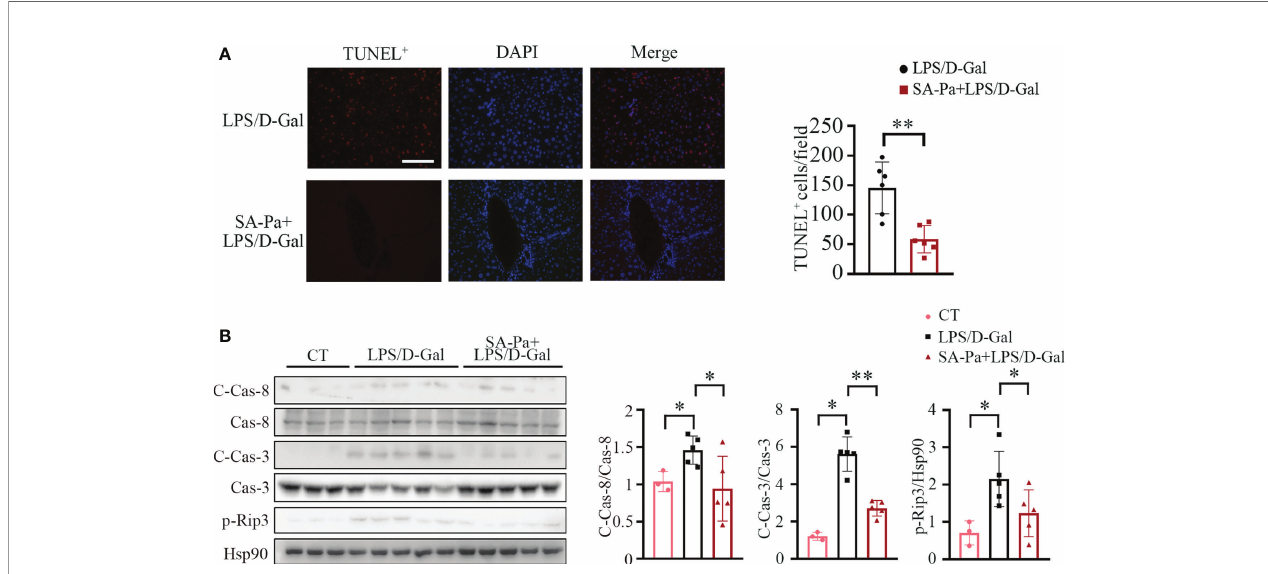
FIGURE 6 | SA-Pa attenuated cell death after the LPS/D-Gal injury. (A) Representative pictures for TUNEL + staining in the liver (left) and quantitative results (right). (B) Western blots (left) and quantitative results (right) for C-Casp-8/Cas-8 (cleaved-Caspase-8/Caspase-8), C-Cas-3/Cas-3, and p-Rip3 levels. (CT group, n = 3; LPS/D-Gal group, n = 5 – 6; SA-Pa group, n = 5 – 6; *p <0.05; **p < 0.01; scale bar = 100 m